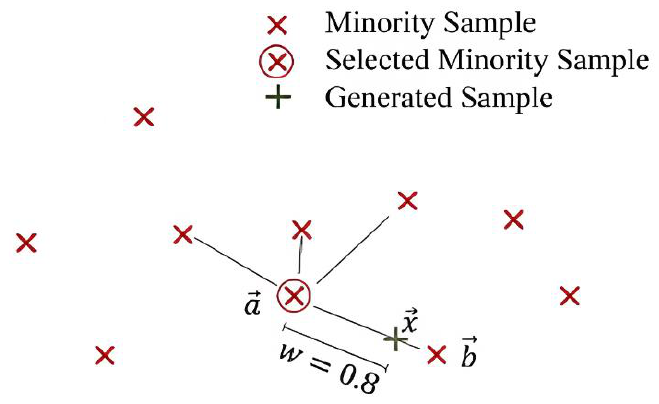
Figure 11. An illustration of the SMOTE filter function with 𝑘 = 4.